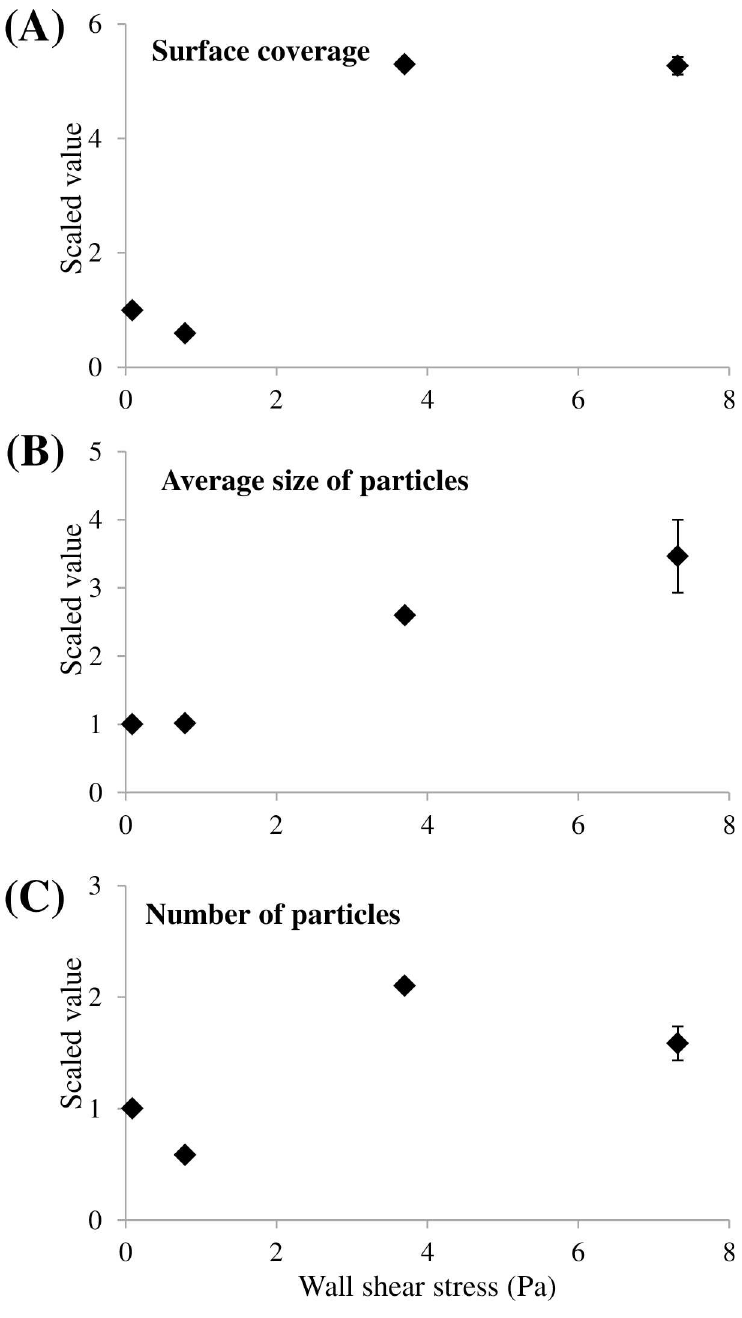
Fig 2. Results of the morphological characterization for Phase 2, shear stress impact test. Three morphologicalparameters–surface coverage (A), numberof particles (B), averagesize of particles (C)–are reportedfor the different wall shear stresses tested (Shear 1 and Shear 2 experiments). Data result from microscopic observations and image analysisof acquiredpictures. As mentioned in Table 2, two and three slides of PP were characterized per reactor for Shear 1 and Shear 2, respectively. In order to compareon the same graph the four wall shear stresses tested, originalvalues were scaled by the value obtainedat 0.09 Pa shear. The y-axis representsthis ratio, henceit is